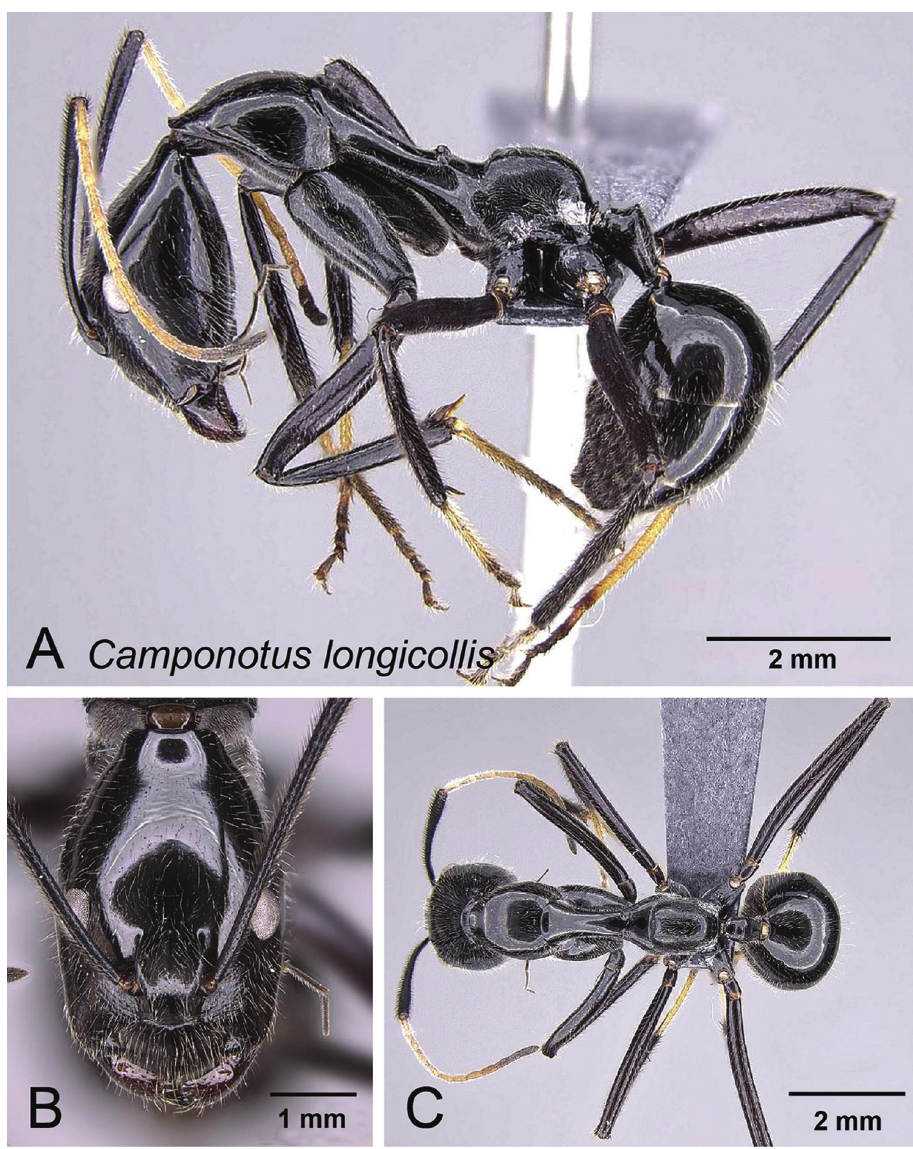
Figure 17. Camponotus longicollis major worker CASENT0763008. A Lateral view B Head in full-face view C Dorsal